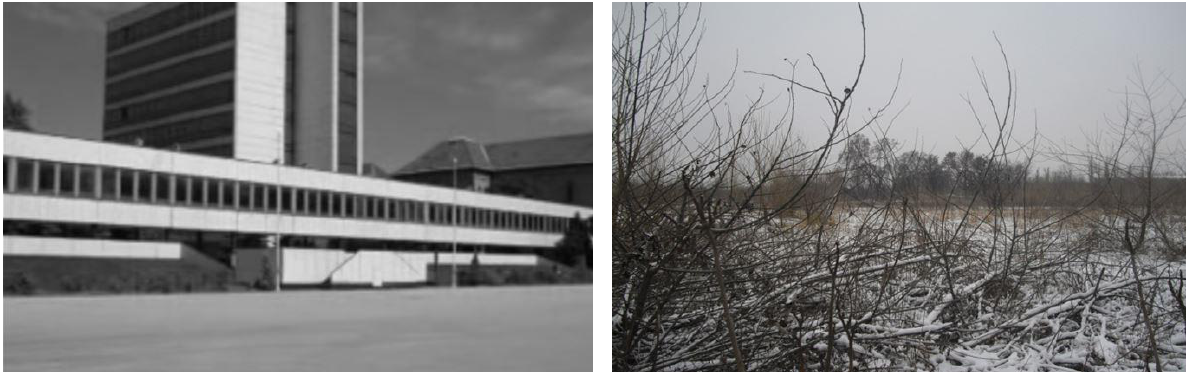
Fig. 7. : János Bolyai Military Technical College 1987 Fig. 8. János Bolyai Military Technical College currently 2018